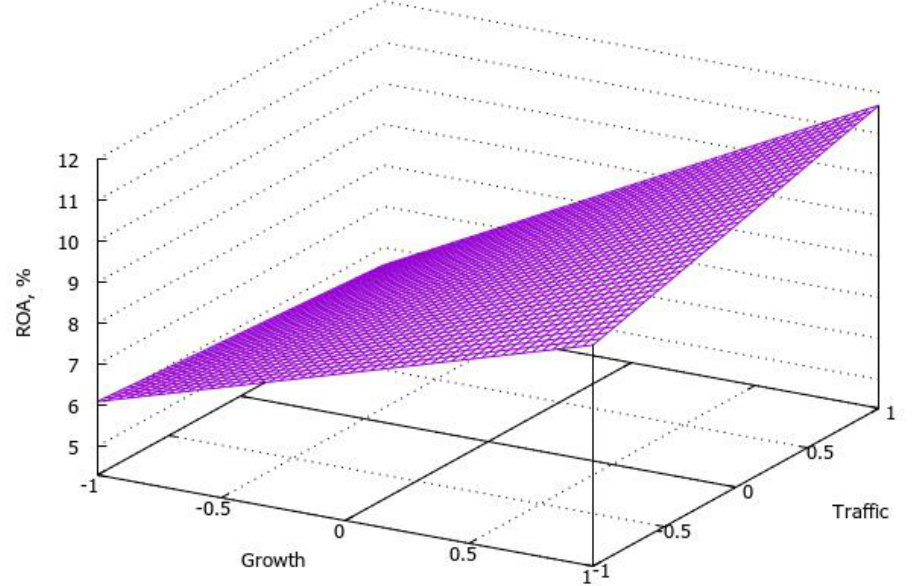
Figure 4. Combined impact of growth and traffic on profitability in model 3 (training sample). ROA is measured as a percentage, while growth and traffic are standardized values.